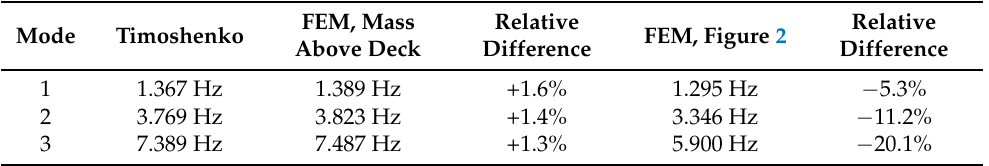
Figure 3. First three shape modes of vertical vibration of a flexible barge. Table 2. Dry natural frequencies obtained analytically and numerically, in Hz; relative differences compared with the analytical